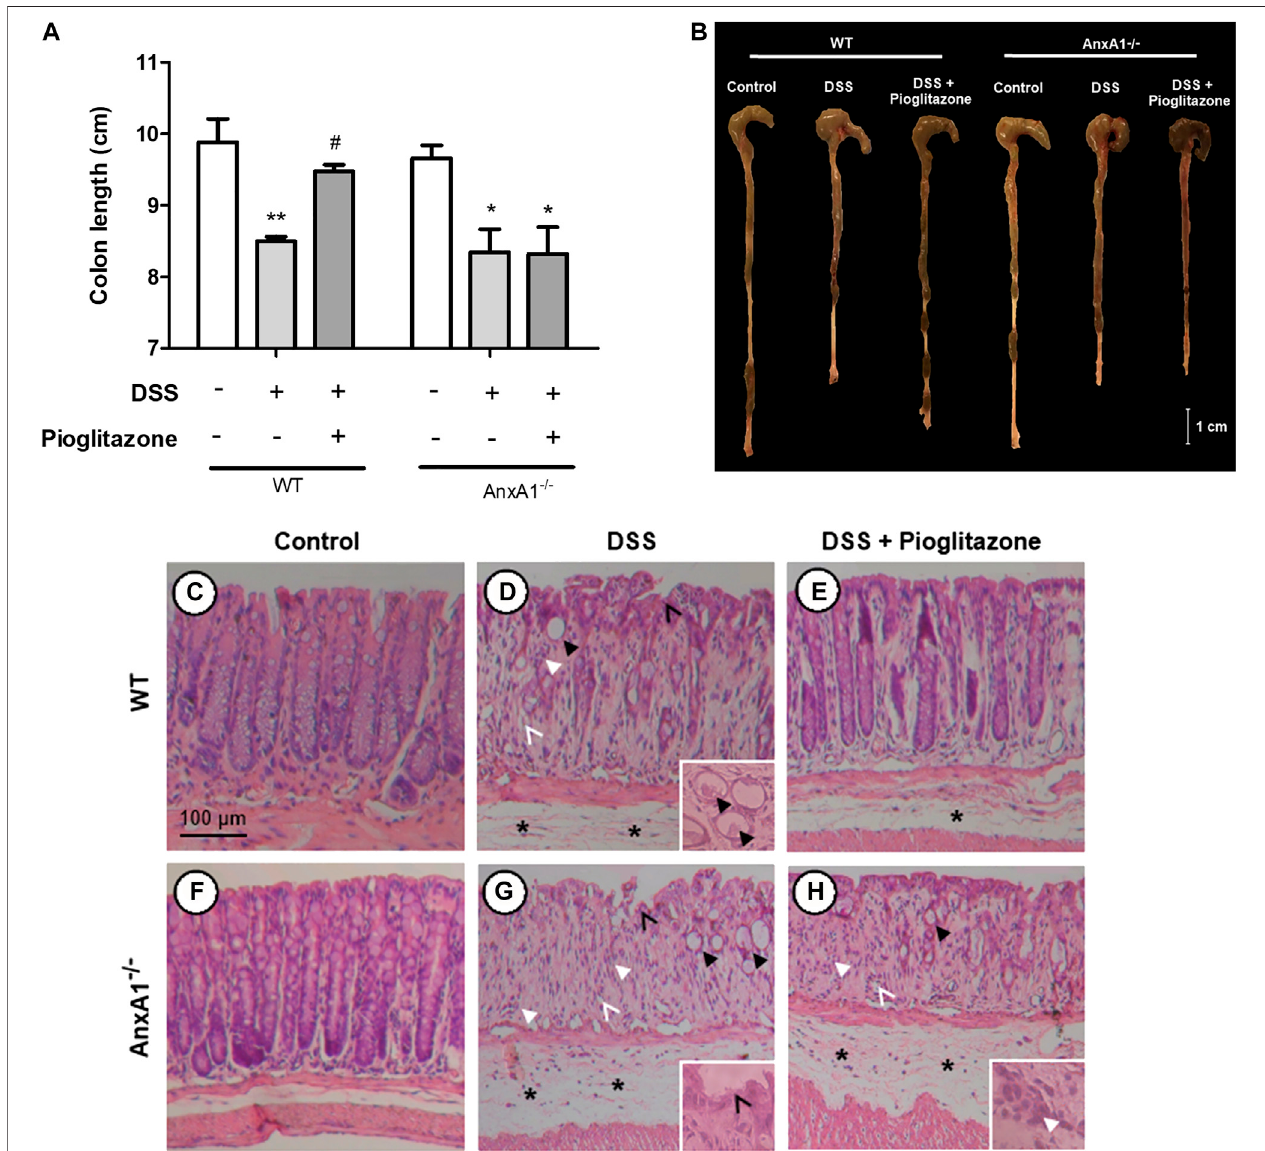
FIGURE 2 | Large intestine extension and colon histoarchitecture on tissue sections. Wild type and AnxA1 − / − mice were euthanized at the end of the experimental model; large intestines were harvested and their extensions measured (A,B) . Paraf fi n-embedded sections were prepared from distal colon fragments andHE-stained;tissuehistoarchitectureandpresenceofDSSlesionswereevaluatedviaopticalmicroscopyforbothwildtype (C – E) andAnxA − /- mice (F – H) ( n (cid:2) 6). Asterisks in histological images indicate edema; thicker black arrows indicate dysplastic crypts (crypt abscess in the detail in D ); thinner black arrows indicate epithelium ulceration; thicker white arrows indicate leukocyte in fi ltration; thinner white arrows indicate hydropic vacuolar degeneration. *, ** p < 0.05, 0.01 in comparisontorespectivecontrolgroup; # p <